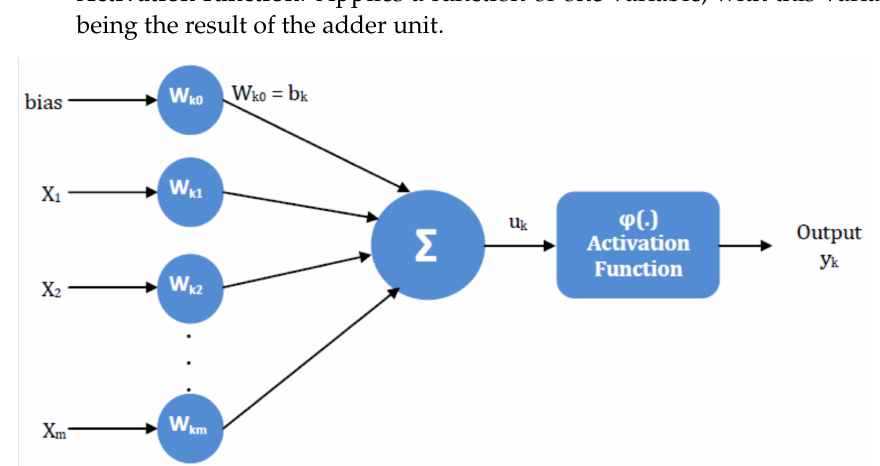
Figure 3. The basic structure element of neural networks, called